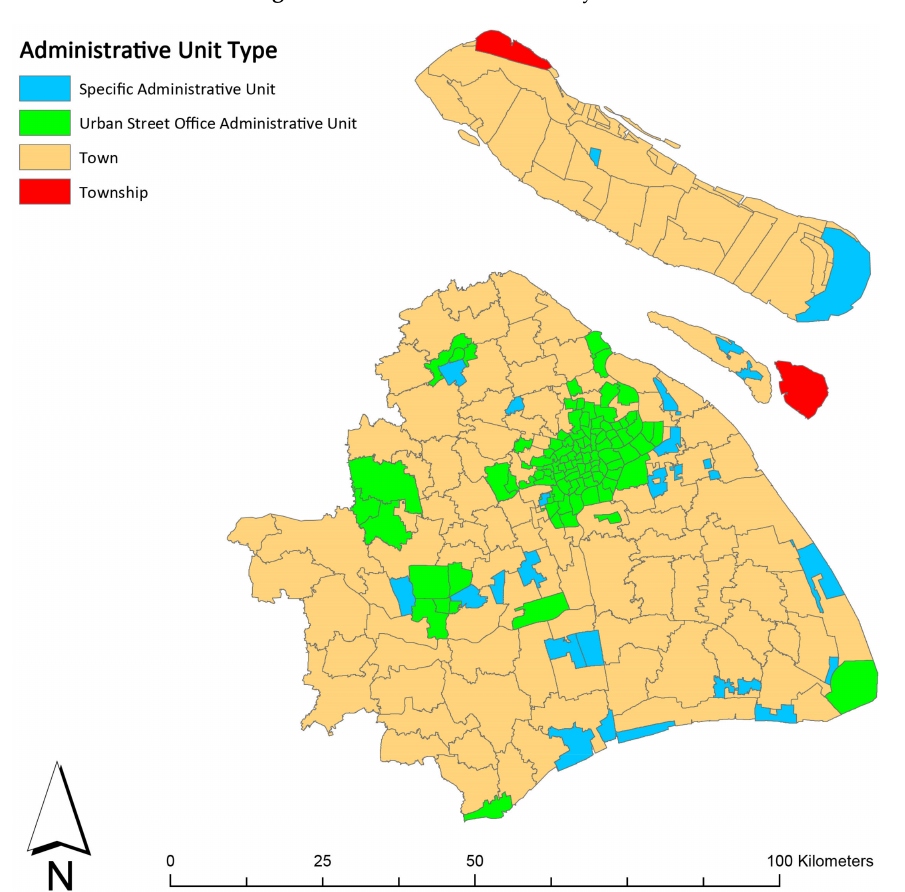
Figure 2. Administrative unit types in